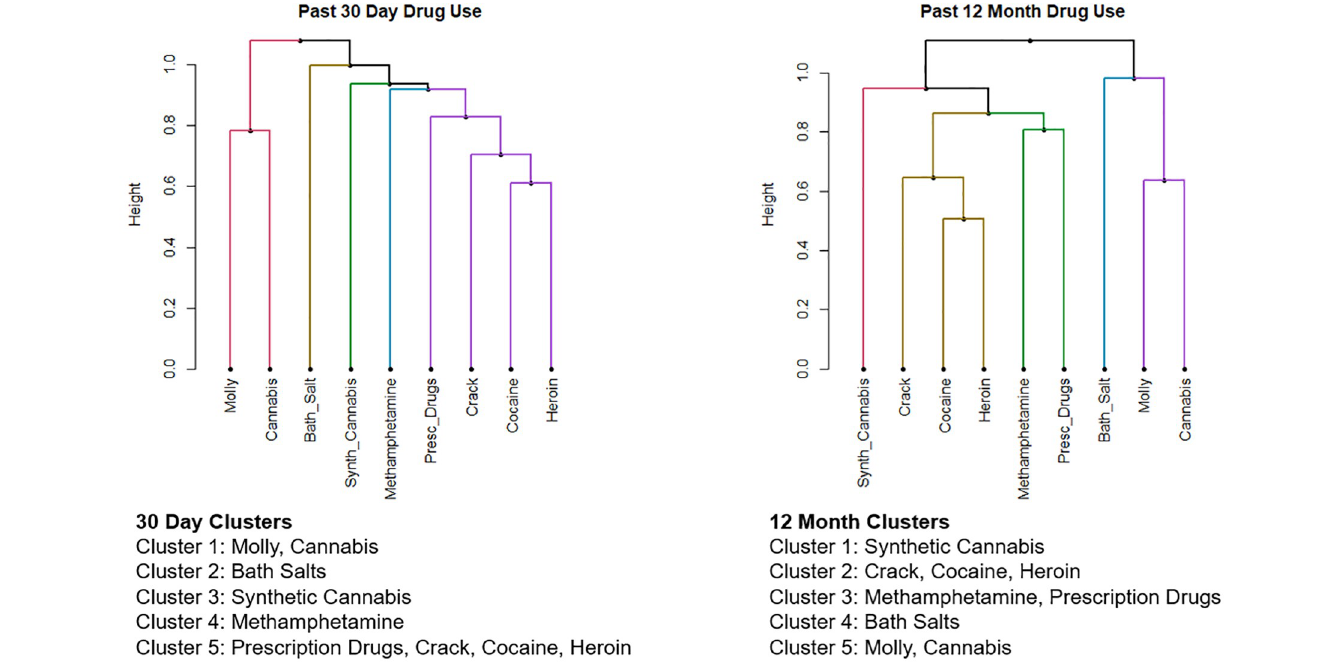
Fig 2. Cluster analysis of past 30-day and past 12-month drug